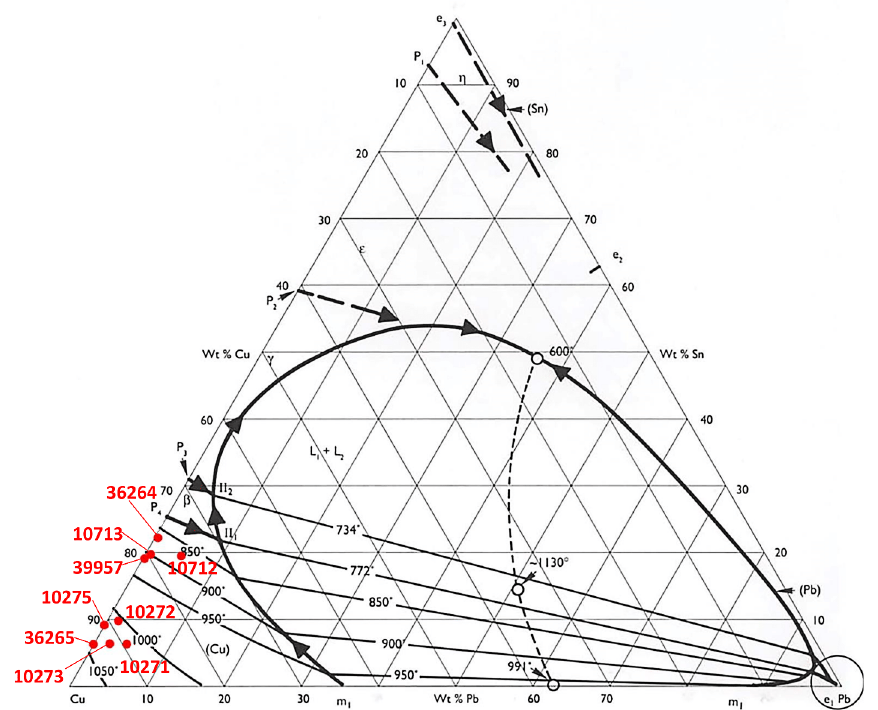
Figure 7. Cu–Sn–Pb ternary-phase diagram of the axes (red dots) indicating the melting temperatures